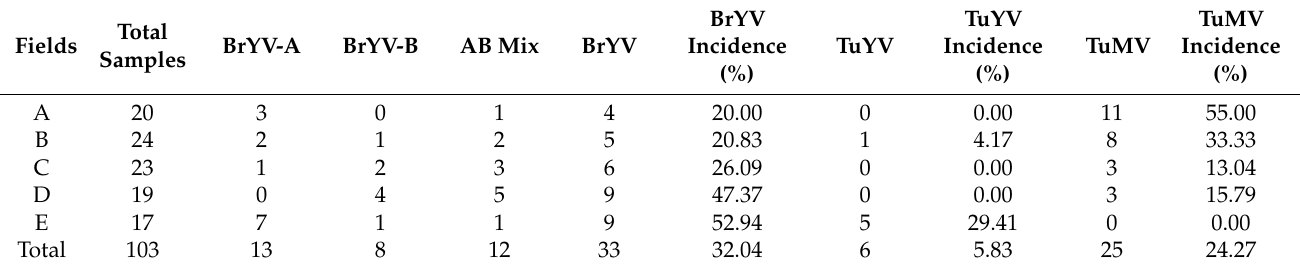
Table 1. The incidence of virus diseases in the field in oilseed rape in Yangzhong.